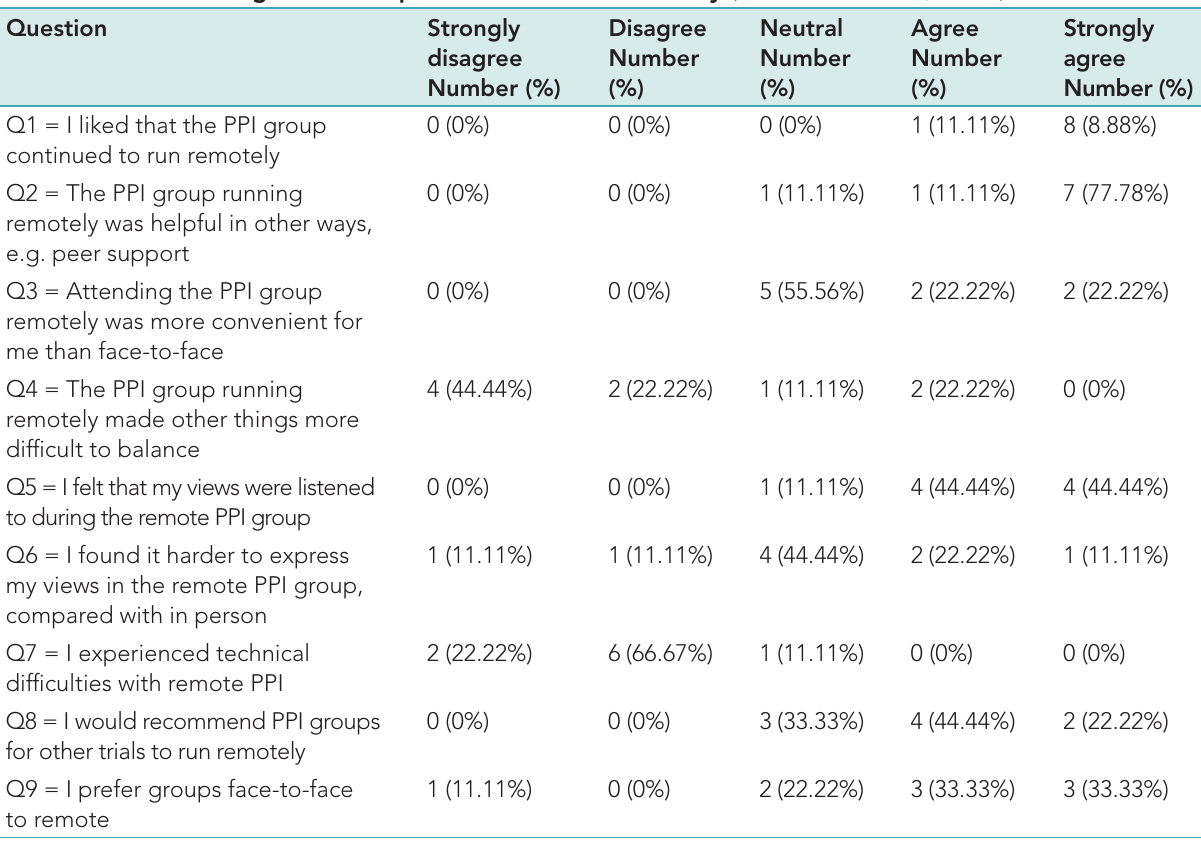
Table 1. Overall findings for each question asked in the survey (Source: Authors, 2023) Question Strongly